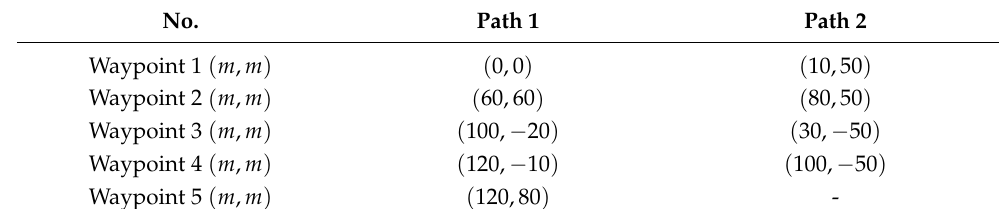
trates the effects of path following for the three algorithms.